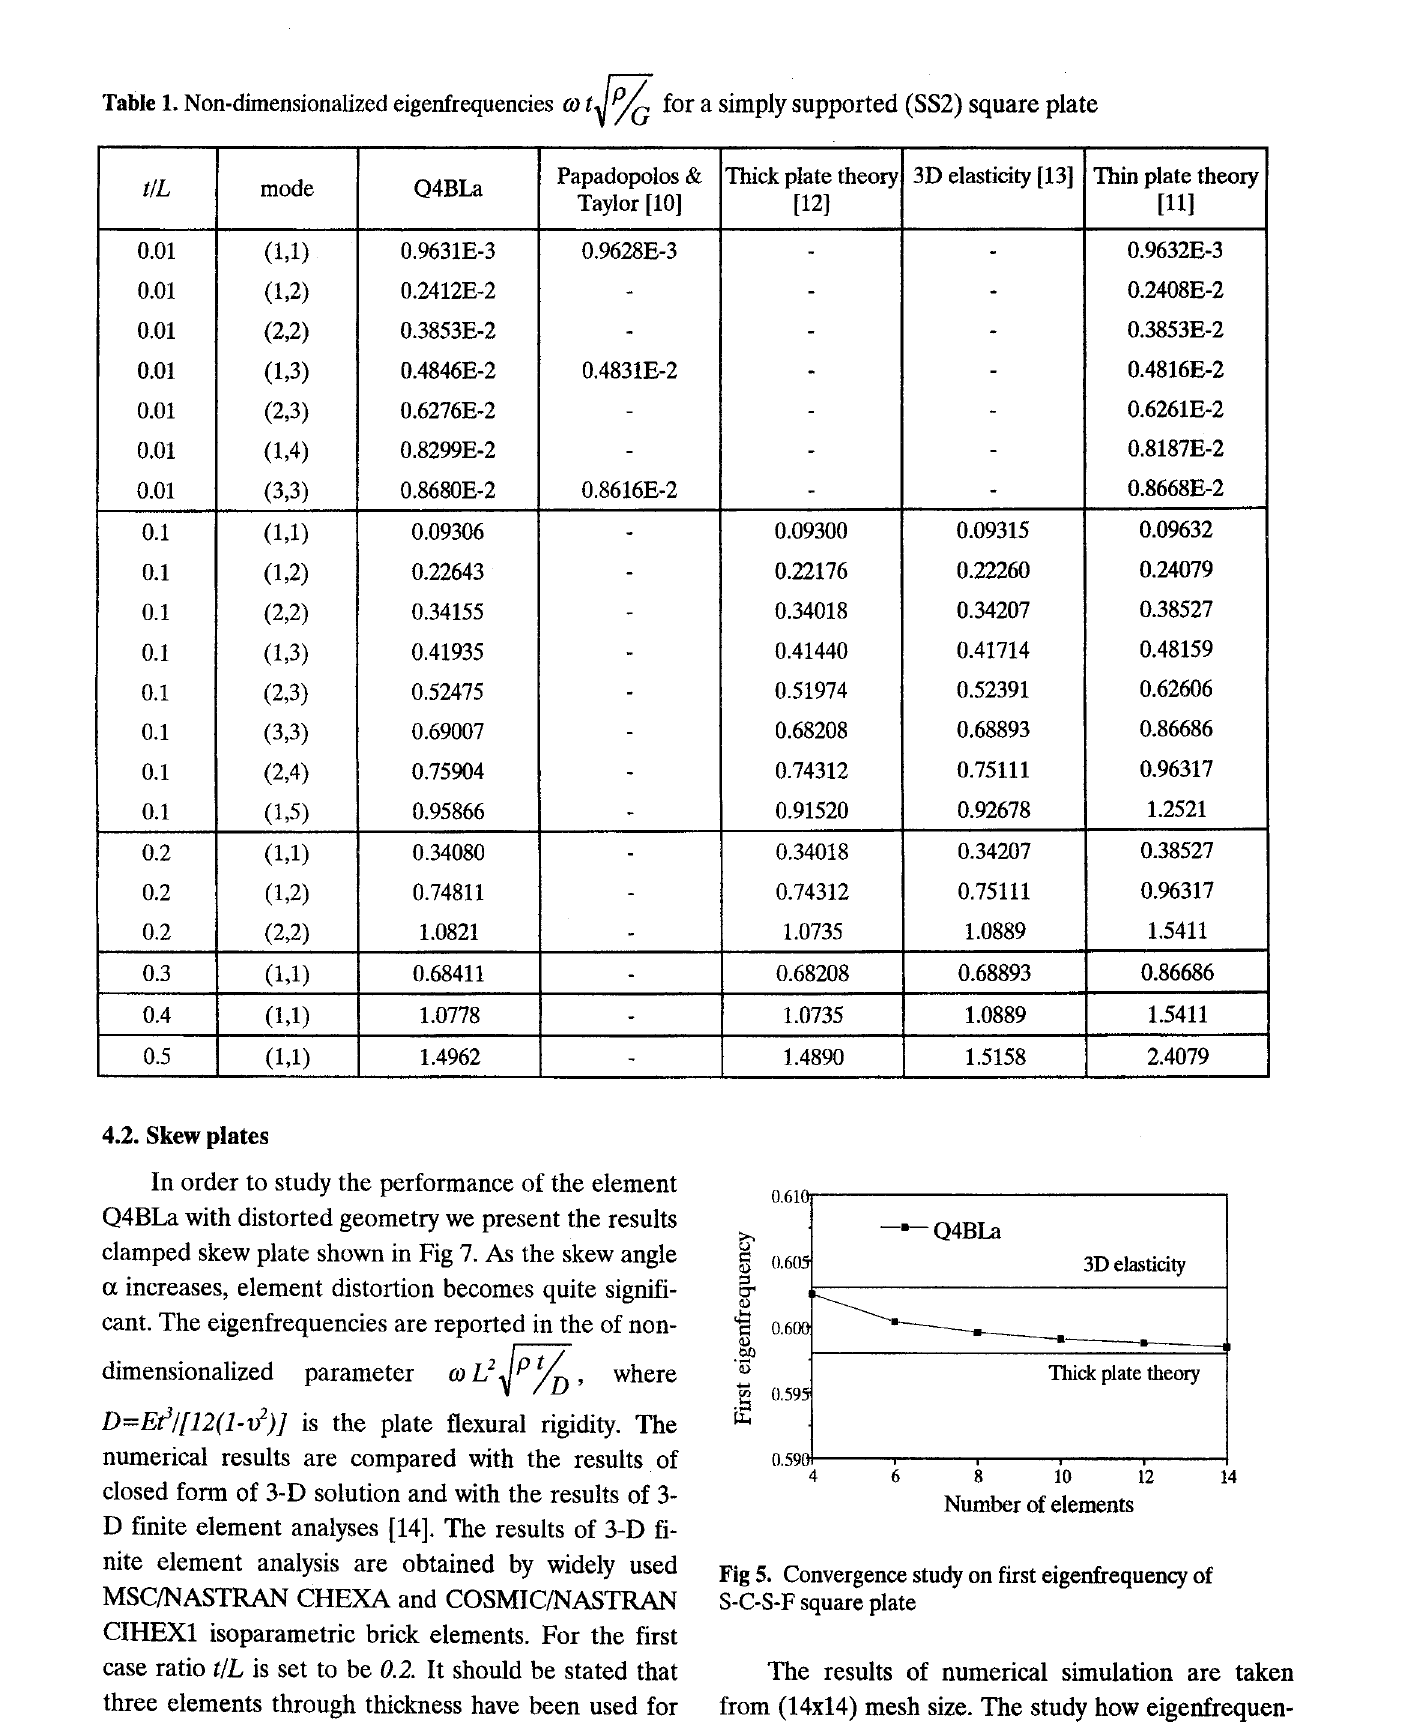
Table 1. Non-dimensionalized eigenfrequencies rot~/{; for a simply supported (SS2) square plate